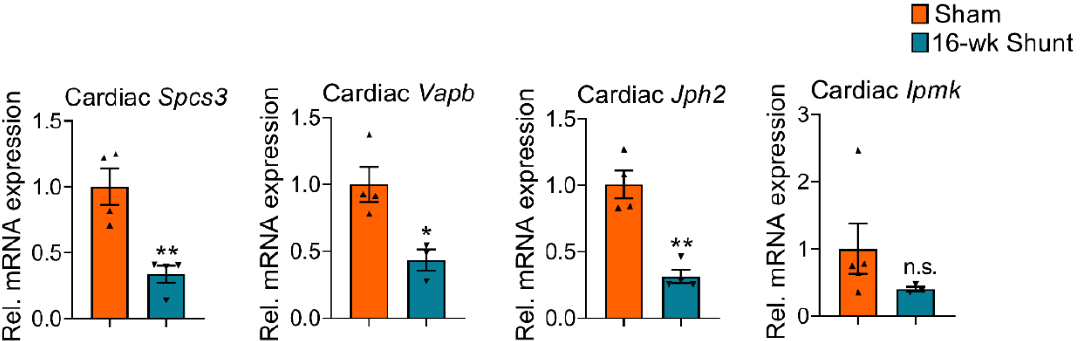
Figure 5. qPCR analysis showing the mRNA expression level of the four selected candidate genes in 16-week-shunt mouse hearts. Values are mean ± SEM, n = 3–4 hearts/group. * p < 0.05, ** p < 0.01 vs. sham, two-tailed unpaired Student’s t -test. n.s., not significant.